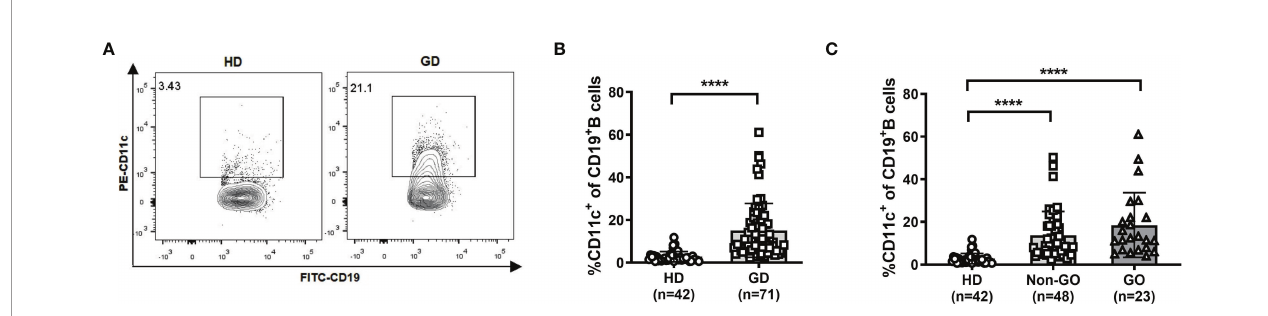
FIGURE 1 | Frequency of CD11c + B cells in healthy donors (HD) and Graves ’ disease (GD) patients. (A) Representative fl ow cytometric plots of HD and GD patients. (B) Frequency of CD11c + B cells in CD19 + B cells of HD and GD patients. (C) Frequency of CD11c + B cells in CD19 + B cells of HD, non-Graves ’ ophthalmopathy (non-GO) patients, and GO patients. Nonnormally distributed data are expressed as the median and IQR, assessed by Mann – Whitney U tests. P < 0.05 was considered statistically signi fi cant. ns, not signi fi cant; **** P